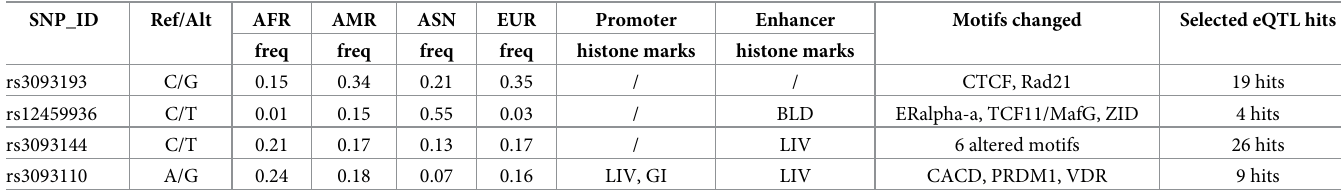
Table 1. Functional annotation of the selected variants provided by HaploReg 4.1.